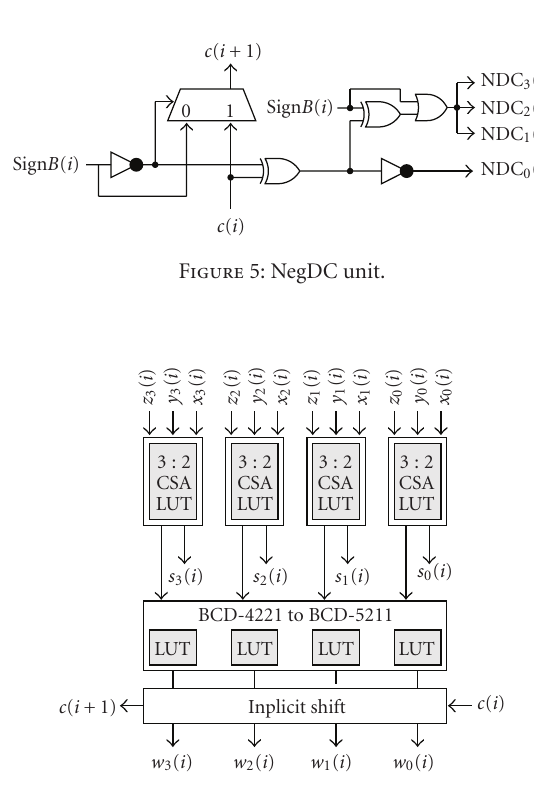
Figure 6: (3 : 2) CSA type1 implementation.